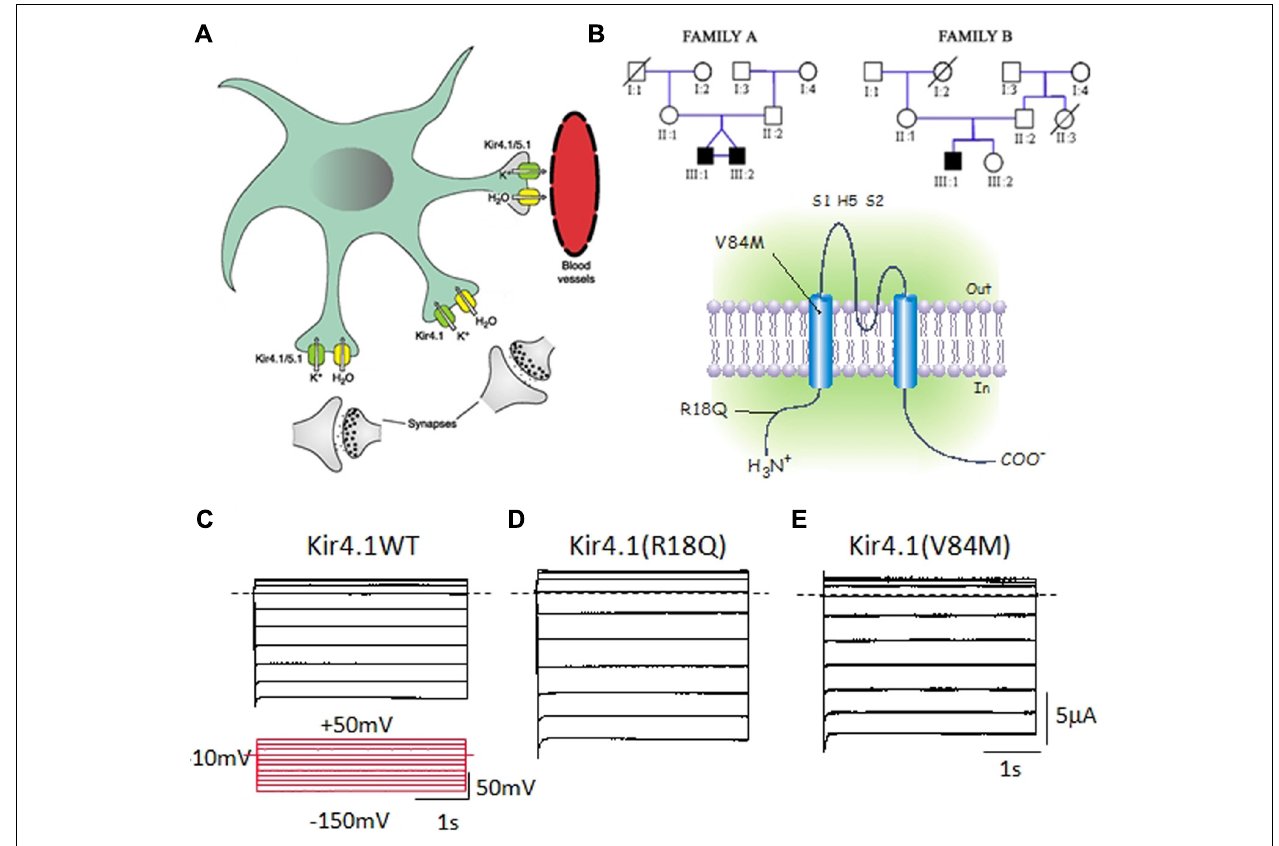
human Kir4.1 subunit with the two variants, R18Q andV84M. (B) Sample current families recorded from Xenopus oocytes expressing equal amounts of Kir4.1WT (C) , R18Q (D) , orV84M (E) mRNA. Notice that mutant channels show increased current amplitudes compared to wild-type. Horizontal dashed lines indicate 0 current level.The pulse protocol is shown as inset in (C) . From Sicca etal.